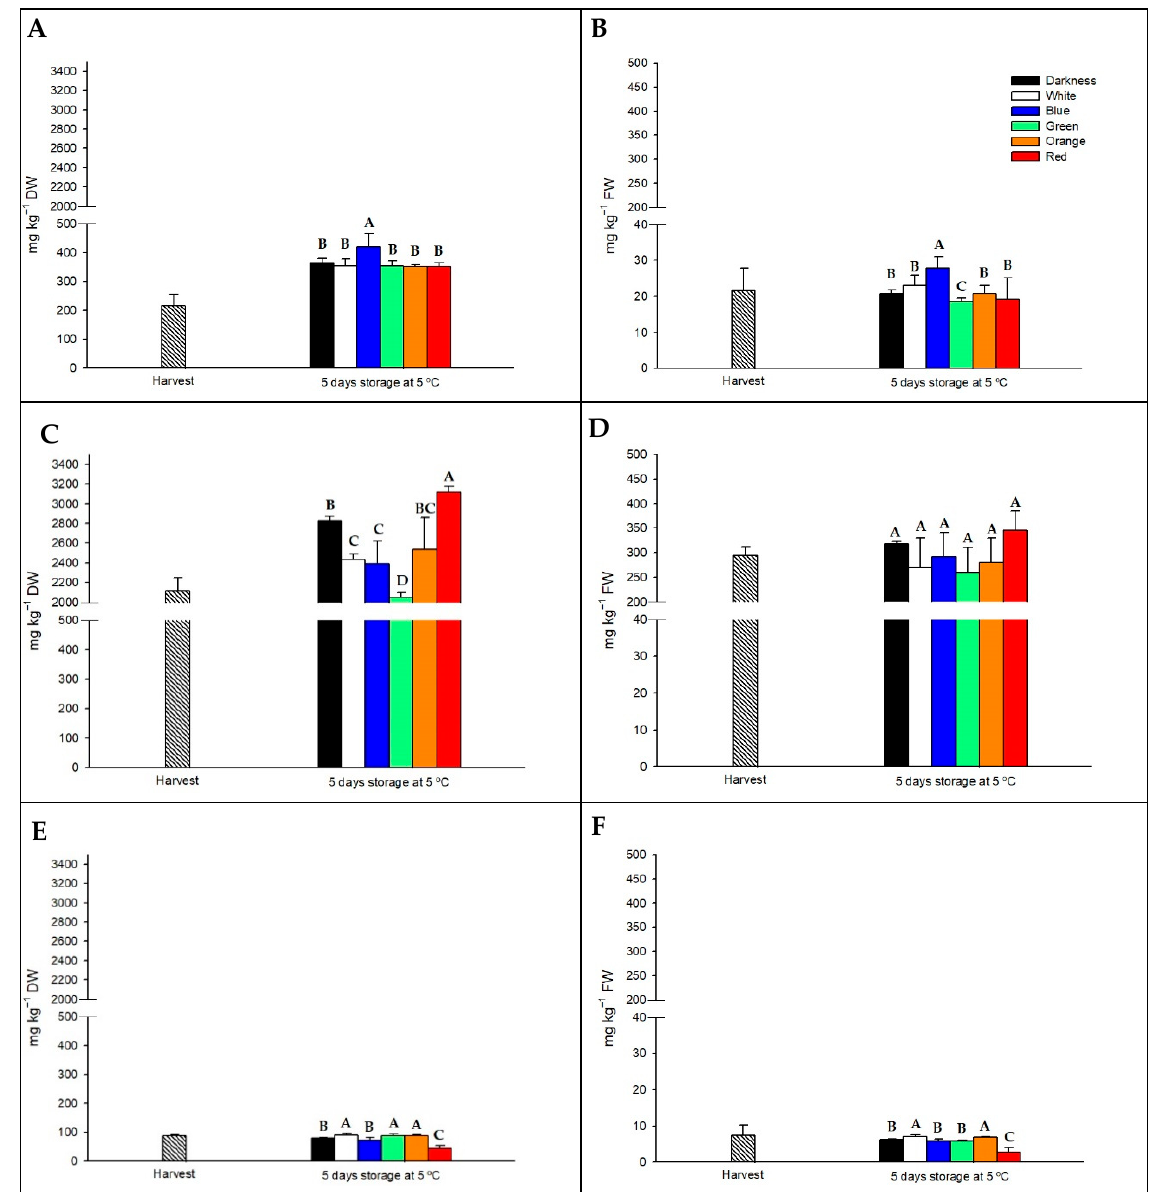
Figure 5. Sulforaphane content of Brassicaceae (( A , B ): rocket; ( C , D ): radish; ( E , F ): tatsoi) sprouts under different wavelengths for 5 days at 5 °C. Left: Dry weight (DW). Right: Fresh weight (FW). Different capital letters denote significant differences ( p < 0.05) among light treatments.